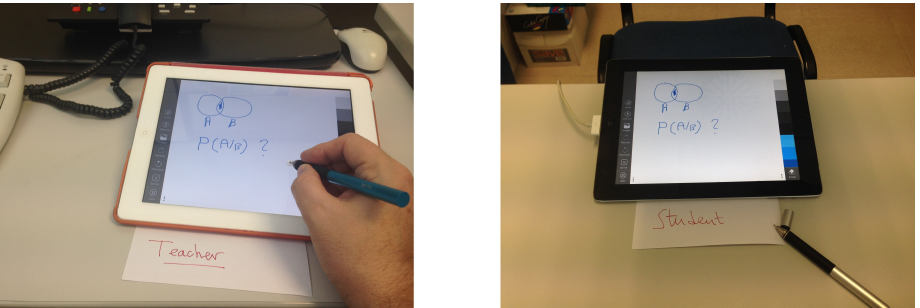
Figure 6. Communication between teacher and student via